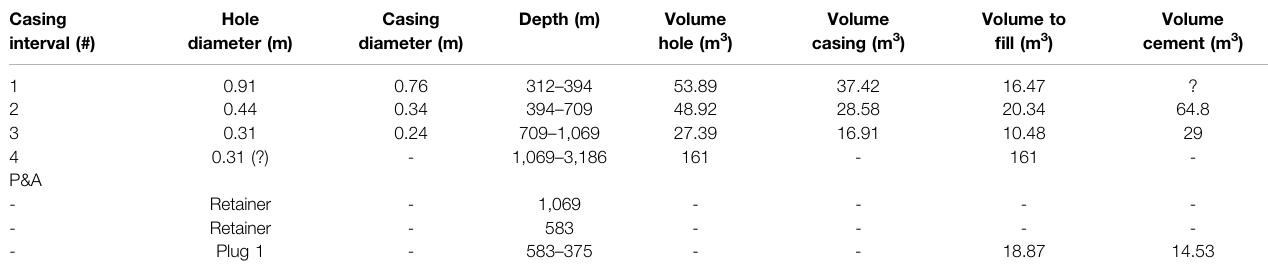
TABLE 1 | Dimensions of well architecture and amounts of used cement obtained from https://factpages.npd.no/en/wellbore/PageView/Exploration/All/2918, well completionreport(Kinnetal.,1998),andErichsenetal.(2012).Thevolumesofthehole/casing/to fi llarecalculatedforthedifferentcasingintervalsassumingvolumesfor ideal cylinder. Only one cement plug is installed ( Figure 3 ). During abandonment, the casing intervals 1 and 2 are cut at 338 m and interval 3 is cut at 622 m. Casing interval (#)